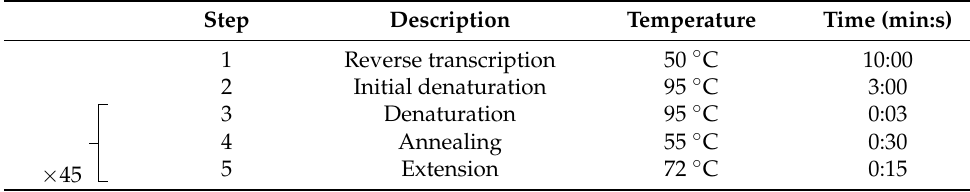
Table 4. Thermocycler settings for each step of the PCR